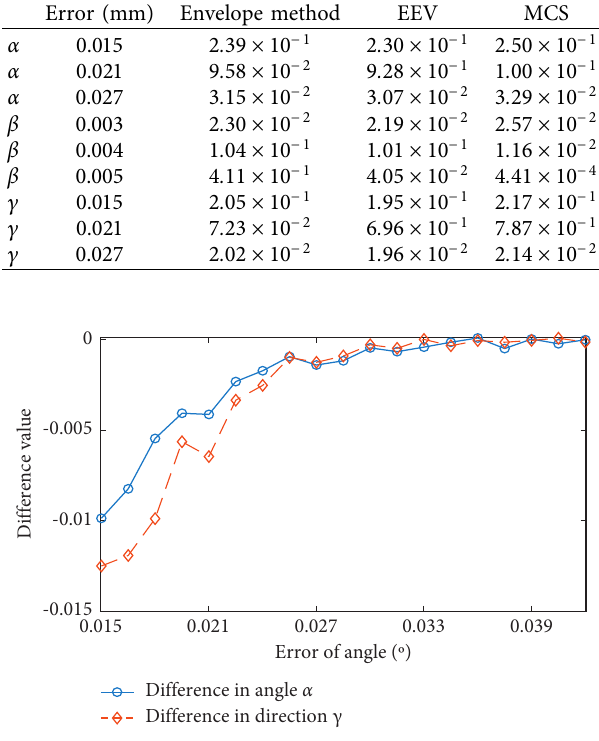
Figure 11: Differences between the envelope method and MCS method in angles.